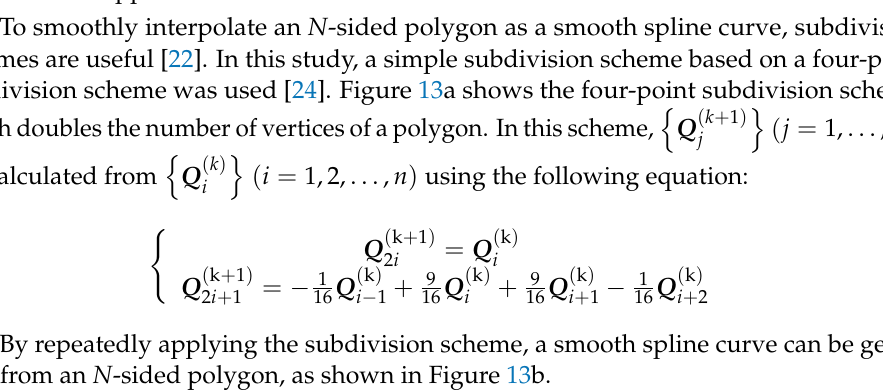
Figure 12. Detailed sectional shape of a stem. ( a ) Median distance in a fan; ( b ) N -sided polygon of a stem sectional shape.